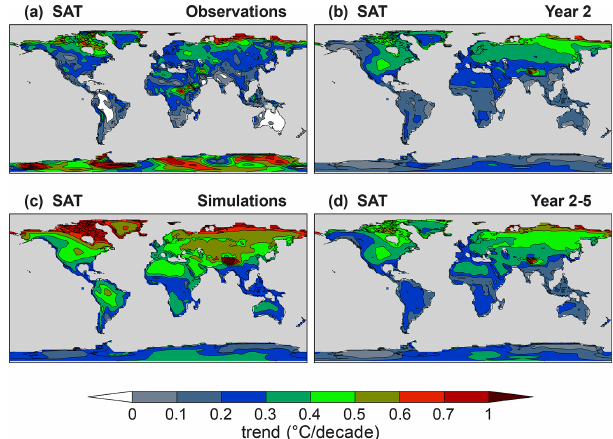
Figure 10. Decadal trends of annual mean near-surface air tempera- ture for (a) observations, (b) Year 2 and (d) Year 2–5 hindcasts, and (c) uninitialized simulations. The verifying observations are from the ERA-40 and ERA-Interim data sets (Appendix